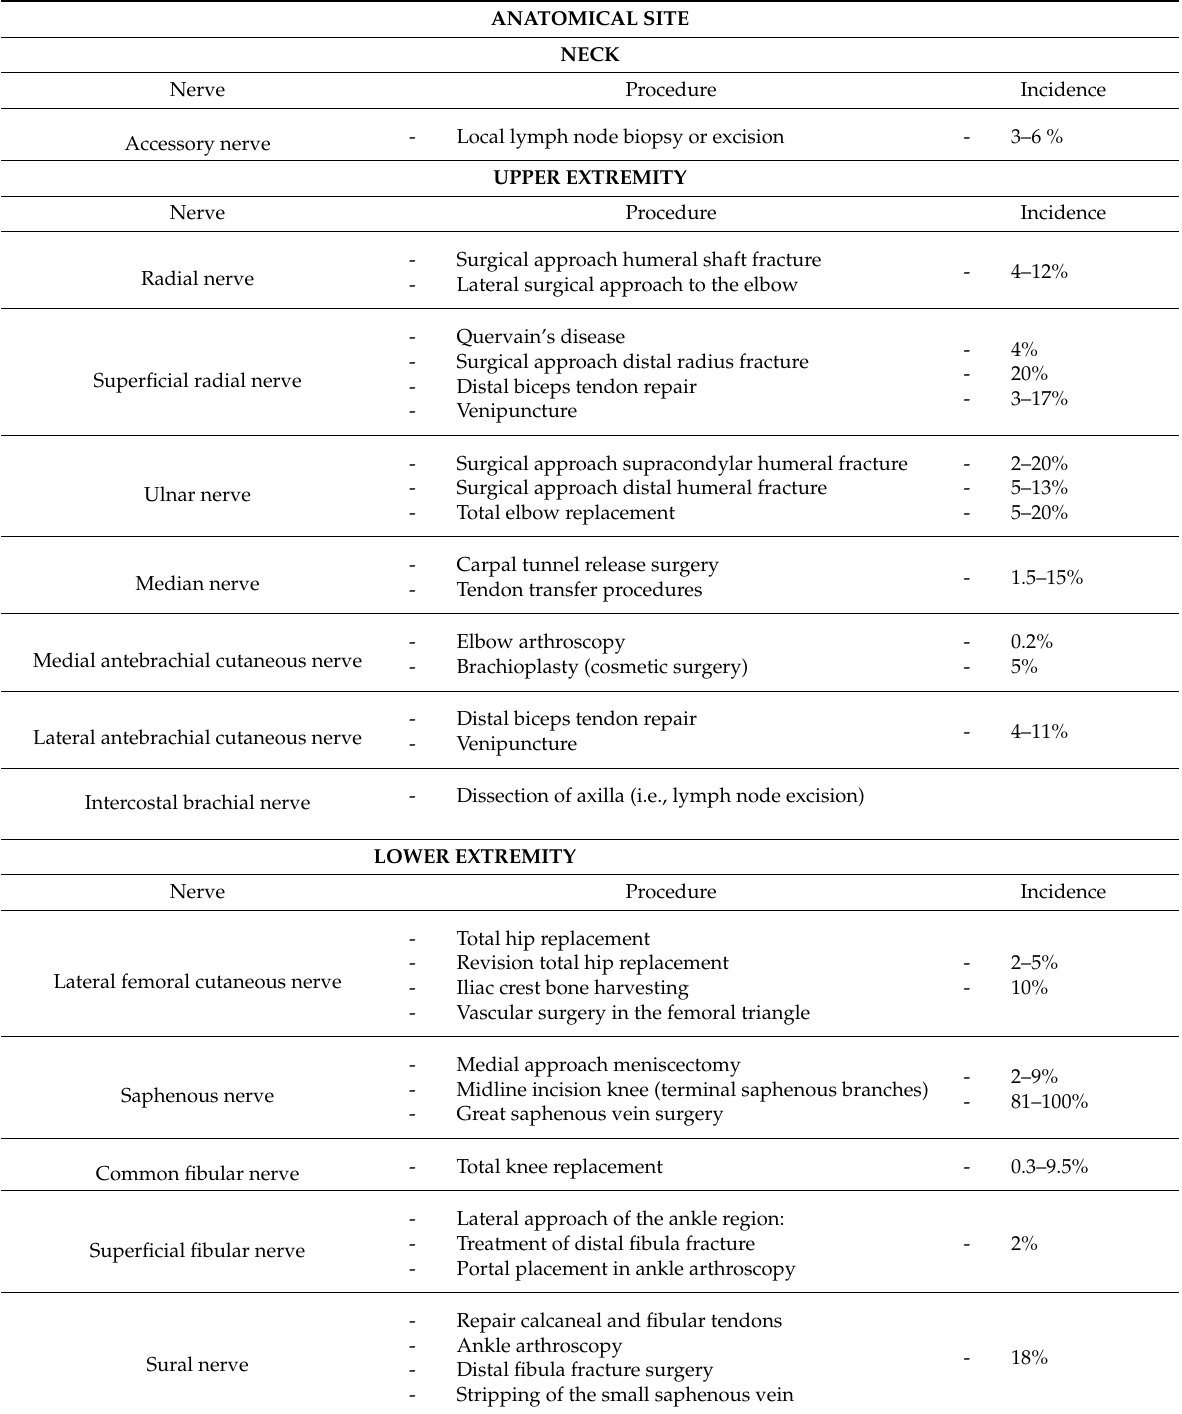
Table 1. Summary of subcutaneous peripheral nerves at risk during various surgical procedures (for references see